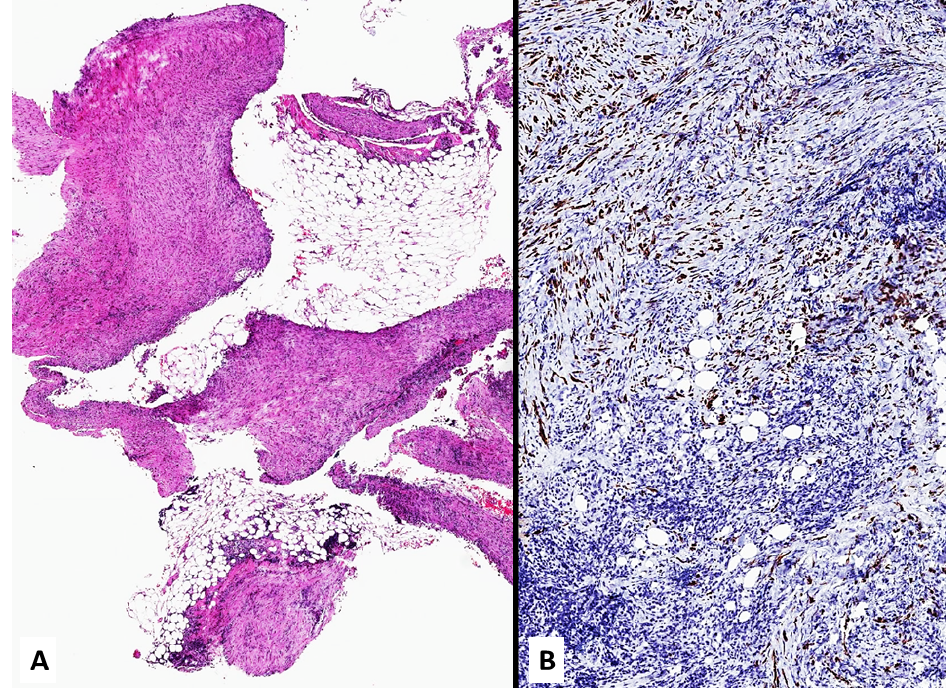
Figure 13. Numerous fragments of parietal pleura with a dense proliferation of spindled cells ( A ) invading soft tissue and expressing pan-cytokeratin ( B ).